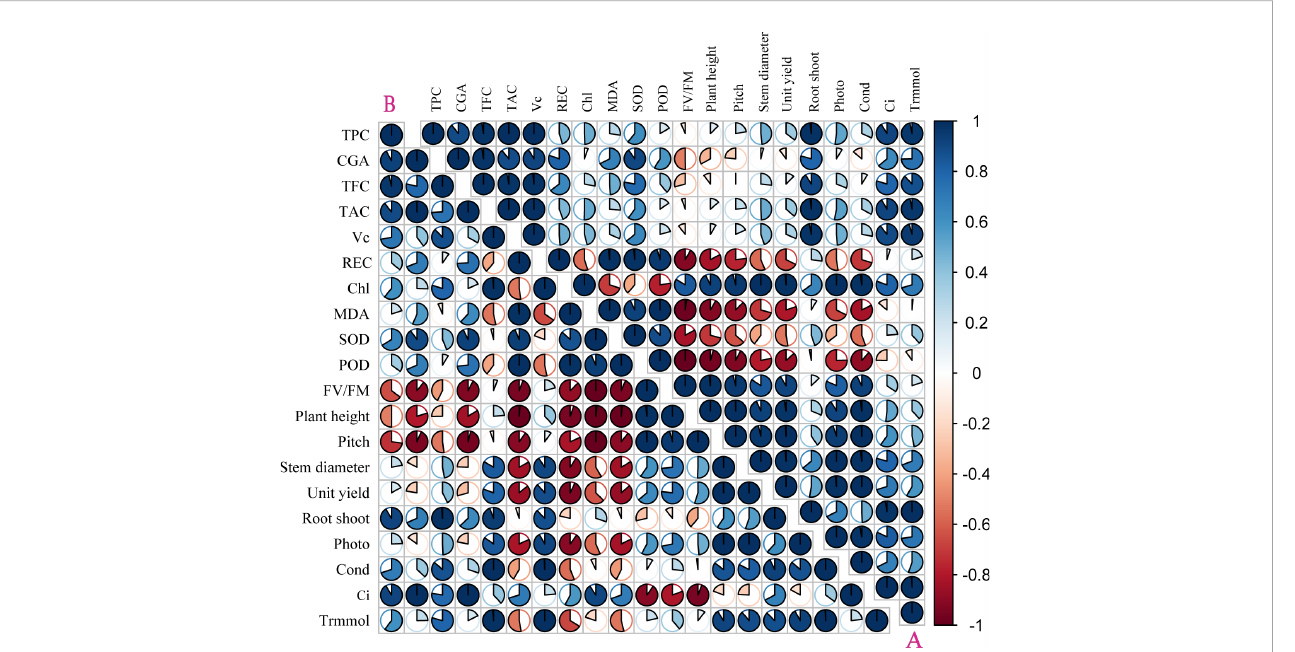
FIGURE 4 Pearson correlation analysis of different physiological of “ Huaxinyangyu ” and “ Jianchuanhong ” , (A) ” Huaxinyangyu ” , (B) ” Jianchuanhong ” (P<0.05). TPC, total phenol; CGA, chlorogenic acids; TFC, total fl avonoid; TAC, total anthocyanin content; V C , vitamin (C) ; REC, relative permeability; Chl, chlorophyll; MDA, malondialdehyde content; SOD, superoxide dismutase; POD, peroxidase; FV/FM, Chlorophyll fl uorescence parameter; Photo, photosynthetic rate; Cond, stomatal conductance; Ci, respiration rate; Trmmol, transpiration rate. (According to the Duncan test, different letters indicate a signi fi cant difference (p< 0.05) among the treatments. The error bars represent the mean ±